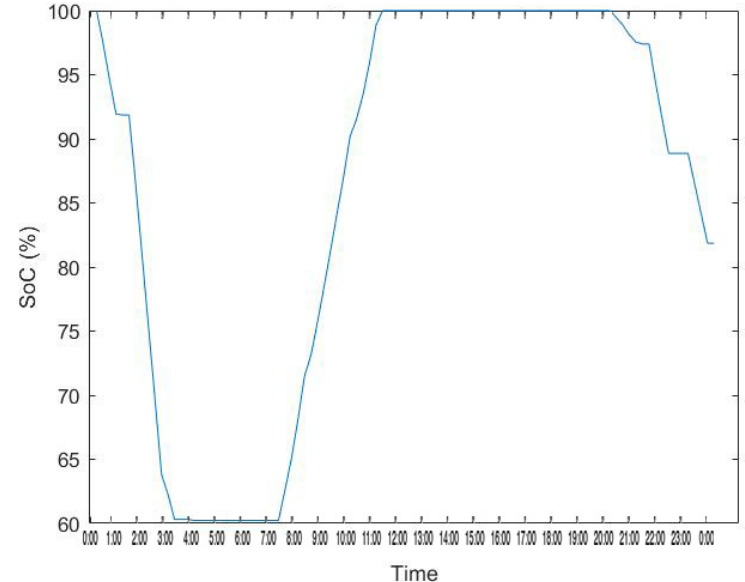
Figure 20. Charging and Discharging of Street Battery in CSPVND.